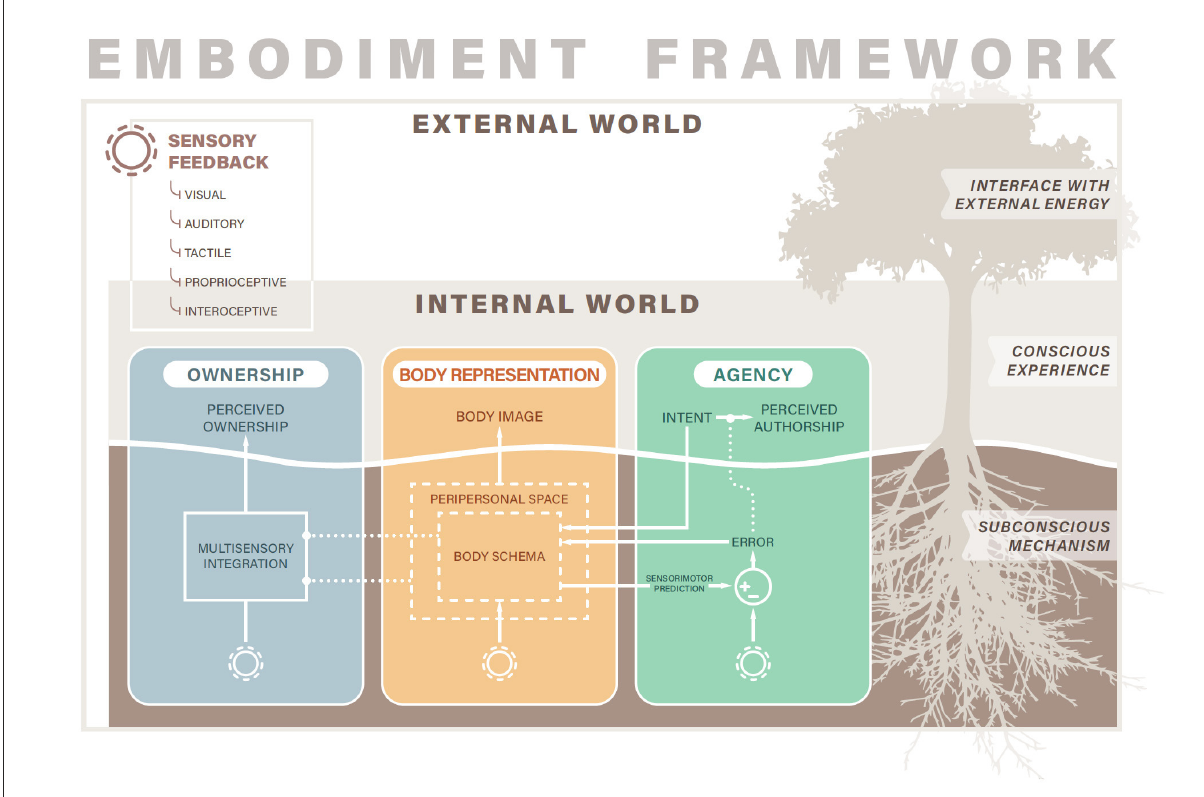
FIGURE1 Embodiment framework. The three domains of ownership, body representation, and agency compose the construct of embodiment. Each domain spans both conscious experiences and subconscious mechanisms. Sensory feedback from the external world and internal to the body enter subconscious neurobiological processes that shape conscious experiences of embodiment. Solid lines indicate causal relationships while dotted lines indicate modulatory relationships. While the conscious domains of ownership, body representation, and agency are separable, the subconscious mechanisms interact. For example, the body schema (part of body representation) forms sensorimotor predictions that enter a comparator (circle with + and − signs) that outputs an error signal that ultimately modulates experiences of agency (dotted line). In addition, both the body schema and peripersonal space influence the multisensory integration process (dotted lines) to constrain the types of objects that can be perceived as